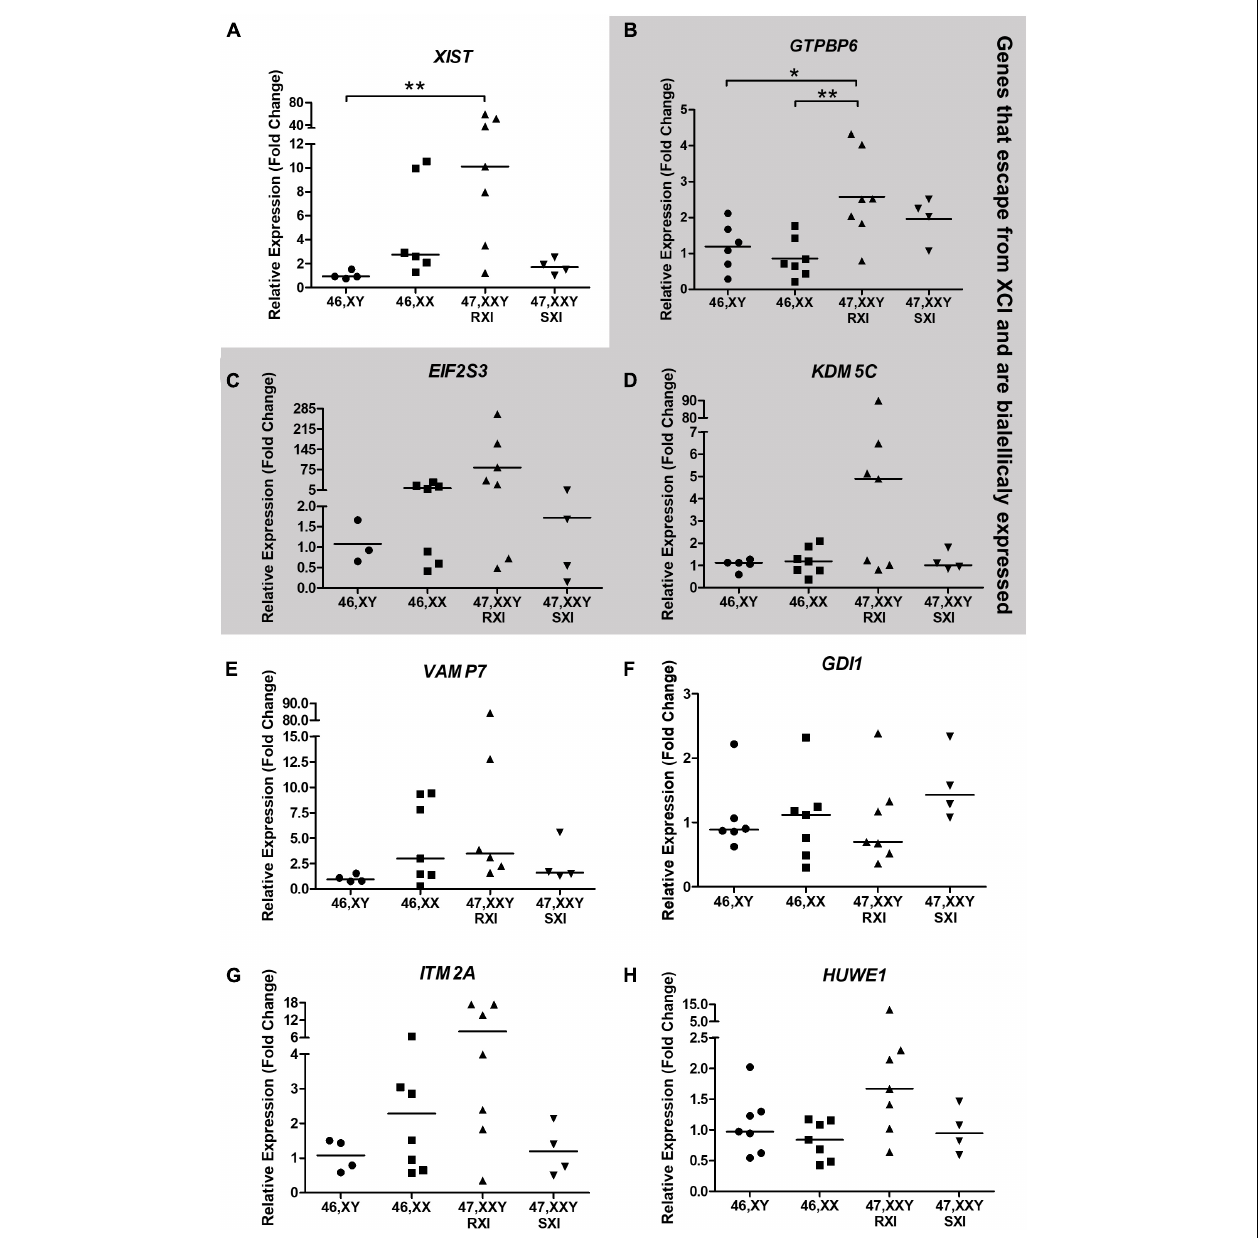
FIGURE 2 | Neurocognitive-related X-chromosome linked gene expression analysis tested in Klinefelter Syndrome patients in comparison to healthy controls. Eight X-linked genes, (A) XIST , (B) GTPBP6 , (C) EIF2S3 , (D) KDM5C , (E) VAMP7 , (F) GDI1 , (G) ITM2A , and (H) HUWE1 , were evaluated. Genes that escape from X-chromosome inactivation and are biallelically expressed are indicated in the gray area. Relative expression (fold change) is represented in relation to males (XY). Note that in (A) , the XIST expression was higher in KS patients with RXI in comparison to male controls ( p = 0.0090), while in (B) , the GTPBP6 expression was higher in KS patients with RXI than in both female and male controls ( p = 0.0059). In (A,C,D,E,F), data are presented as the median and the statistical test used was Kruskal-Wallis followed by the Dunn test. In (B,G,H) , data are presented as the mean, and statistical analysis used was one-way ANOVA followed by the